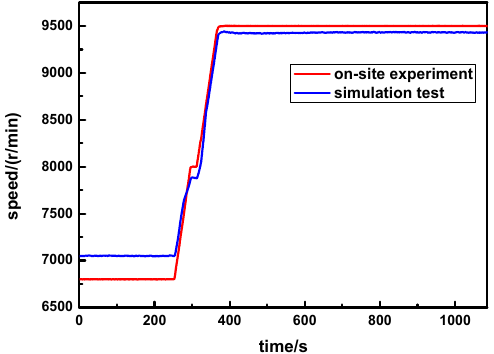
Figure 7. The speed comparison of on-site data and simulation data.